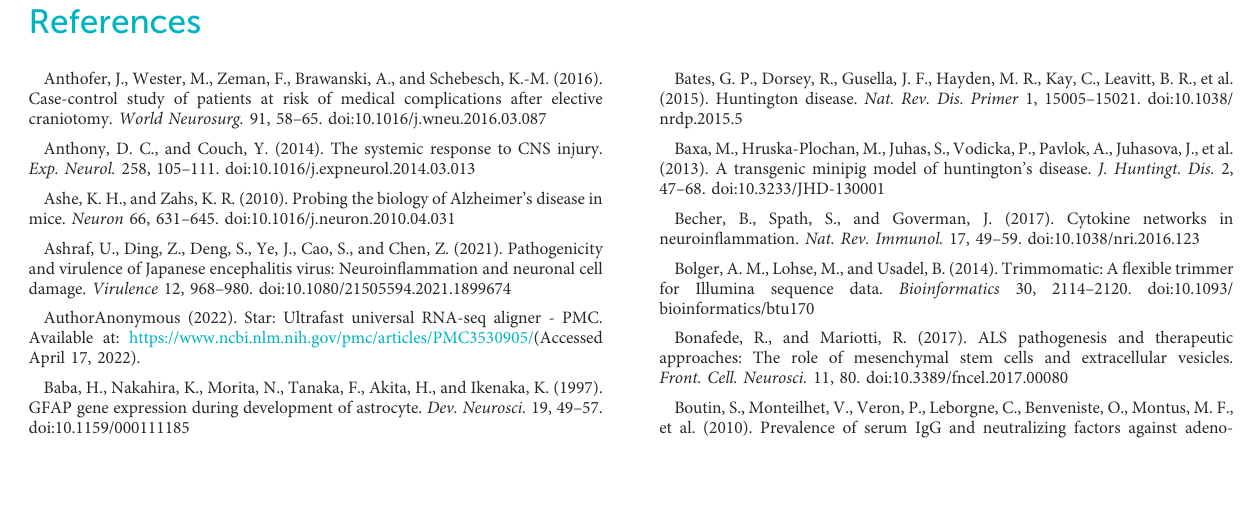
SUPPLEMENTARY FIGURE S2 Immuno fl uorescent staining of the pig ’ s spinal cord injected with AAV-GFP or saline. (A – L) Double immuno fl uorescent labeling and quanti fi cation of neurons (NeuN) (A – C) , astrocytes (GFAP) (D – F) , microglial (Iba1) (G – I) and oligodendrocytes (Olig2) (J – L) of saline- or AAV-GFP-injected-wild type pigs. GFP positive cells are shown in green, NeuN, GFAP, Iba1 and Olig2 positive cells are shown in red. Data are analyzed by Student ’ s T-test and presented as mean ± SEM. n = 3 animals per group. (M) Western blotting of the spinal cord of saline- or AAV-GFP-injected pigs with antibodies against synapsin-1, NeuN, GFAP and Iba1. Vinculin served as a loading control. (N) Quantitation of the ratios of synapsin-1, NeuN, GFAP or Iba1 to vinculin on the western blots. Data are analyzed by student ’ s T-test and presented as mean ± SEM. n = 3 animals per group. SUPPLEMENTARY FIGURE S3 Examination of in fl ammatory factors in the pig ’ s brain stem and spinal cord after intravenous injection of saline or AAV-GFP. (A,B) Western blotting of the brain stem (A) and spinal cord (B) of saline-or AAV GFP- injected pigs with antibodies against TGF β , IL17, IL6, IL4, IL1 β and TNF α . Vinculin served as a loading control. Quantitation of the ratios of TGF β , IL17, IL6, IL4, IL1 β and TNF α to vinculin on the western blots are presented beneath the blots. Data are analyzed by Student ’ s T-test and presented as mean ± SEM. n = 3 animals per group. SUPPLEMENTARY FIGURE S4 Examination of in fl ammatory factors in the pig ’ s peripheral tissues after intravenous injection of saline or AAV-GFP. (A,C) Westernblotting of the heart, muscle, spleen, testis, liver, lung, kidney of saline-or AAV GFP- injected pigs with antibodies against TGF β , IL17, IL6, IL4, IL1 β and TNF α . Vinculin served as a loading control. (B,D) Quantitation of the ratios of TGF β , IL17, IL6, IL4, IL1 β or TNF α to vinculin on the western blots. Data are analyzed by student ’ s T-test and presented as mean ± SEM. n = 3 animals per group. SUPPLEMENTARY FIGURE S5 Heat map of correlation of expression levels between WT and